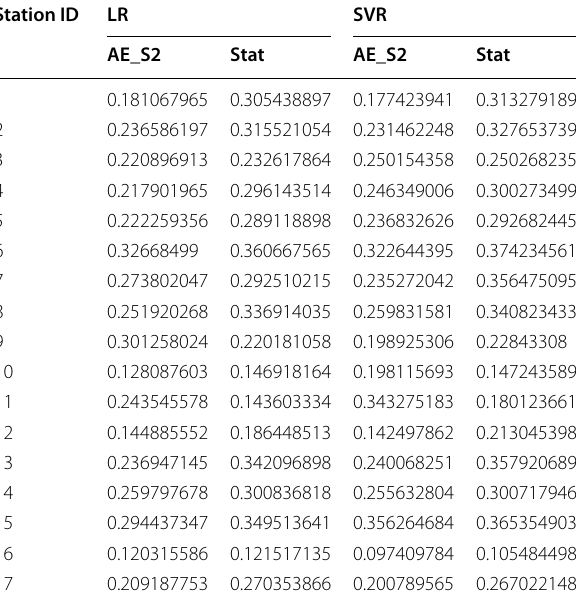
Table 3 Comparison of day-ahead prediction